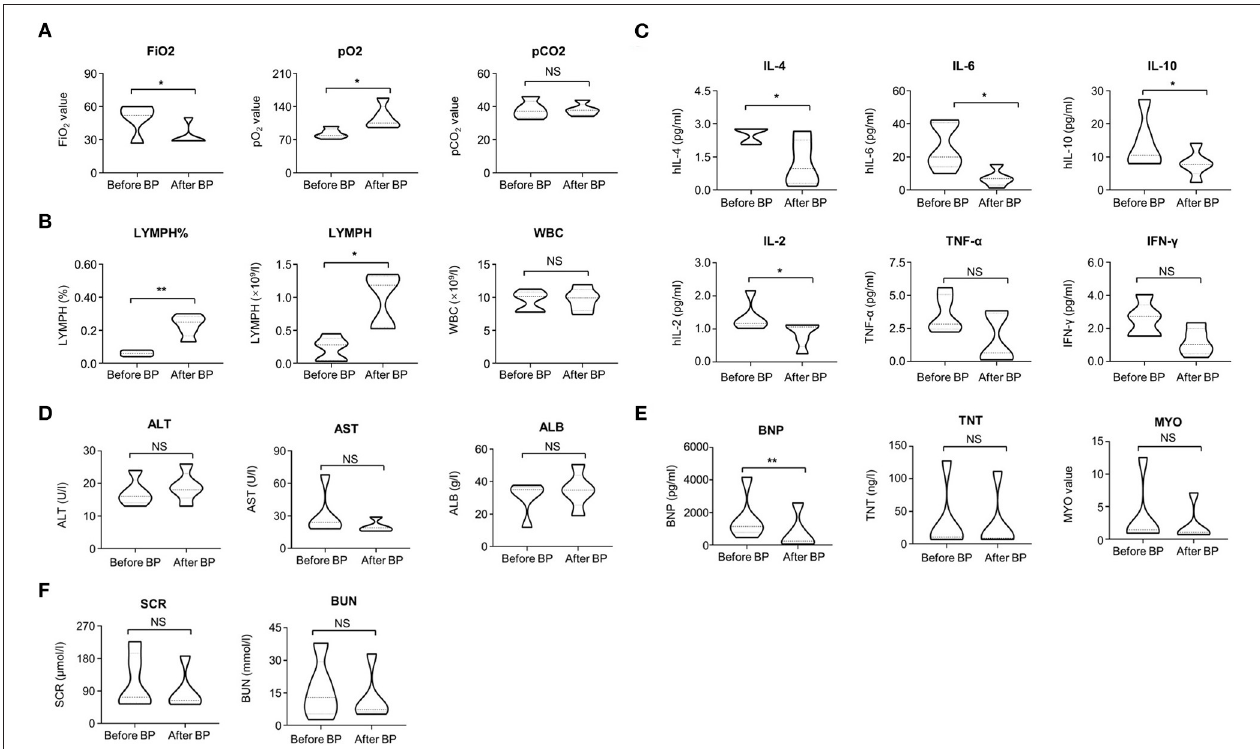
FIGURE 2 | The variations of clinical parameters before and after blood purification. (A) The variations of FiO 2 value, PO 2 value, PCO 2 value in the patients before and after blood purification treatment. (B) The variations of LYMPH (%), LYMPH and WBC (10 9 /L) in the peripheral blood of the patients before and after blood purification treatment. (C) The variations of proinflammatory cytokines (IL-2, IL-4, IL-6, IL-10, TNF- α , IFN- γ ) in the peripheral blood of the patients before and after blood purification treatment. (D) The variations of AST, ALB, and ALT in the patients before and after blood purification treatment. (E) The variations of BNP, TNT, MYO in the patients before and after blood purification treatment. (F) The variations of SCR and BUN in the patients before and after blood purification treatment. The data were shown as violin diagrams. All the data were shown as Mean ± SEM ( N = 5 individuals). * P < 0.05; ** P < 0.01; NS, not